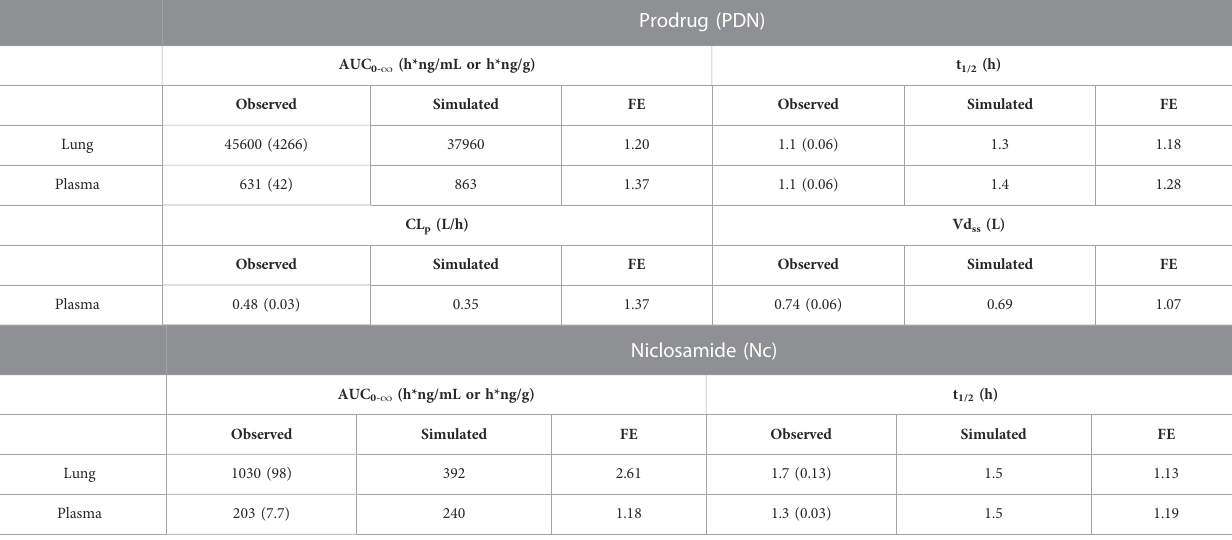
TABLE 6 Observed and simulated pharmacokinetic parameters of PDN and Nc in plasma and lung tissues after IV dose of 3 mg/kg PDN in hamsters. Data were presented as mean (SD). Prodrug (PDN) AUC 0- ∞ (h*ng/mL or h*ng/g) t 1/2 (h) Observed Simulated FE